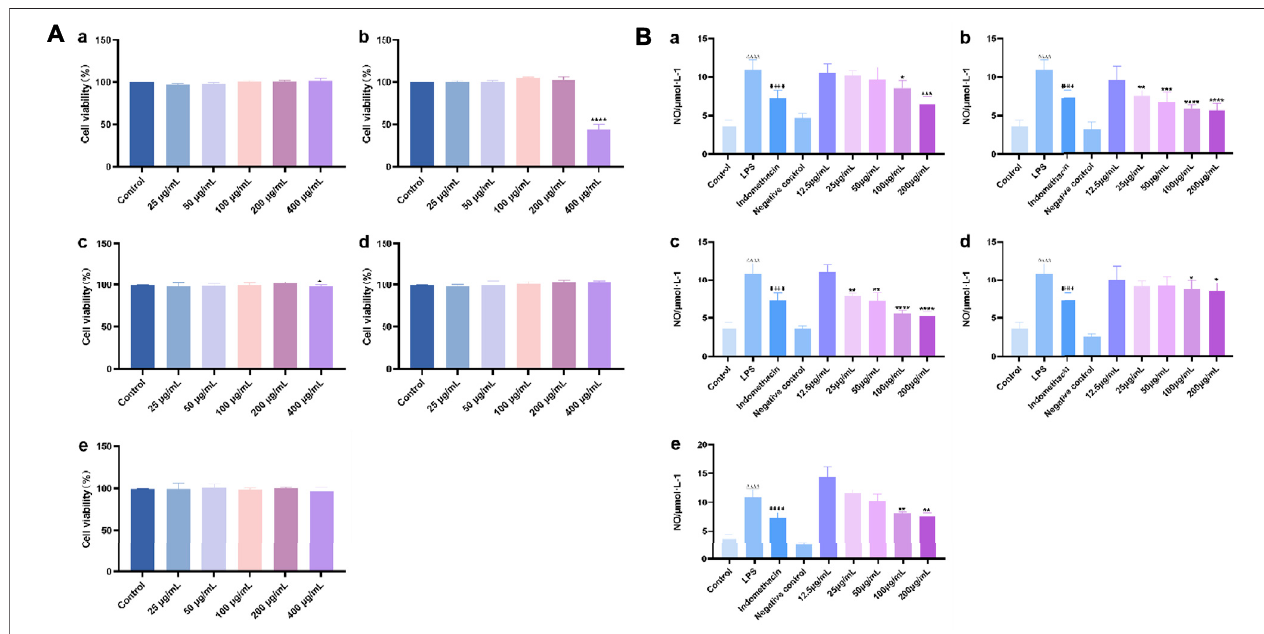
FIGURE 4 | (A) Effect of the four O. vulgaris extracts on viability of RAW 264.7. (Aa) alcohol extract. (Ab) ethyl acetate extract. (Ac) n-butanol extract. (Ad) water extract. (Ae) petroleum ether extract. Data are presented as means ± SD, n (cid:2) 5. * means p < 0.05, ** means p < 0.01, *** means p < 0.001, **** means p < 0.0001 comparedwithcontrolgroup; (B) EffectsofDifferentcrudeextractsof O.vulgaris onNOsecretioninRAW264.7cellsinducedbyLPS. (Ba) alcoholextract. (Bb) ethylacetate extract. (Bc) n-butanol extract. (Bd) water extract. (Be) petroleum ether extract. Data are presented as means ± SD, n (cid:2) 5. * means p < 0.05, ** means p < 0.01, *** means p < 0.001, **** means p < 0.0001 compared with LPS group. #### means p < 0.0001 compared with LPS group. △△△△ means p < 0.0001 compared with control group.